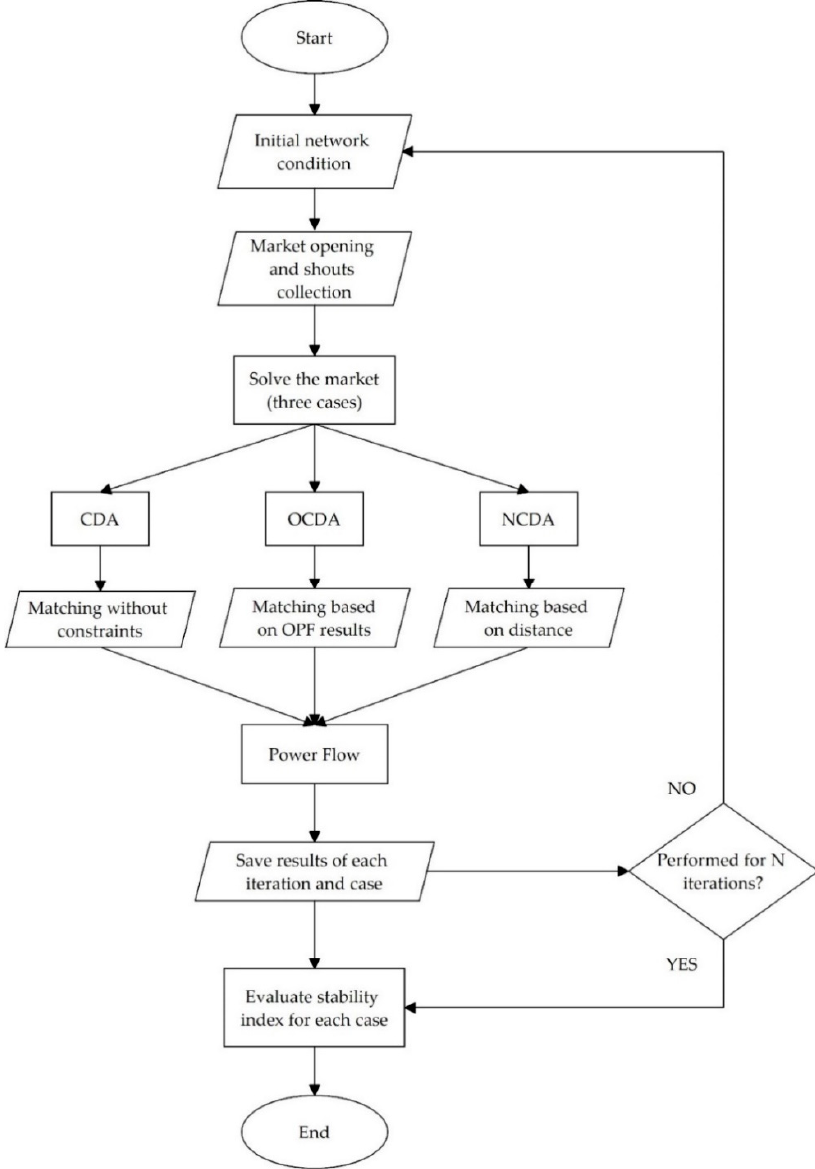
Figure 5. The flowchart of the CDA, OCDA and NCDA validation phase.